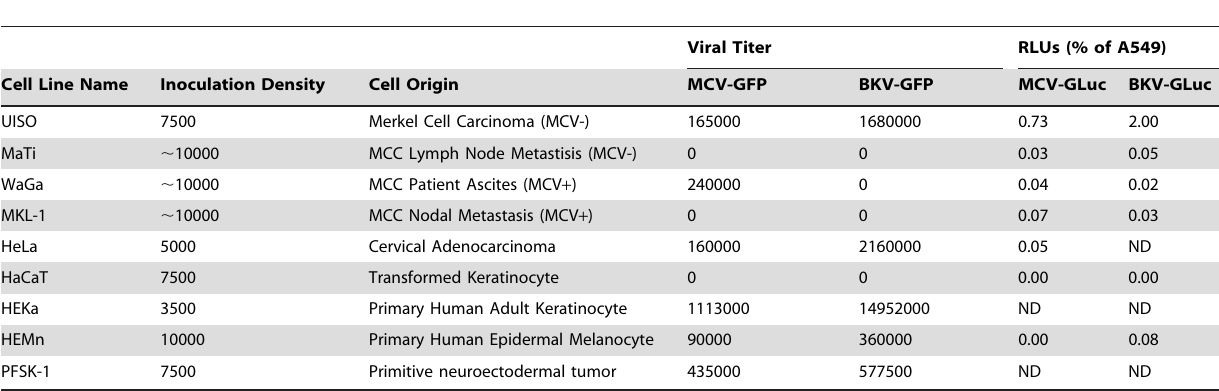
Table 3. Transducibility of other potentially relevant cell lines and primary